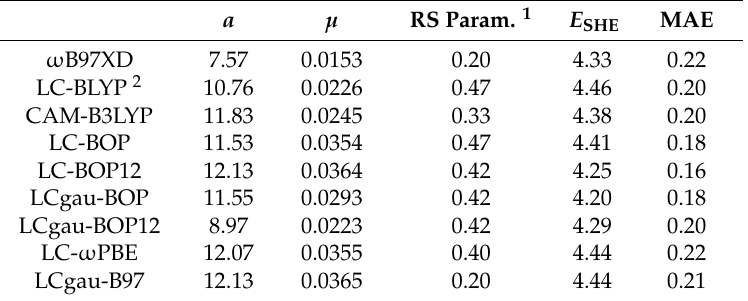
Table 3. The parameters of the PCIS scheme and MAE by range-separated